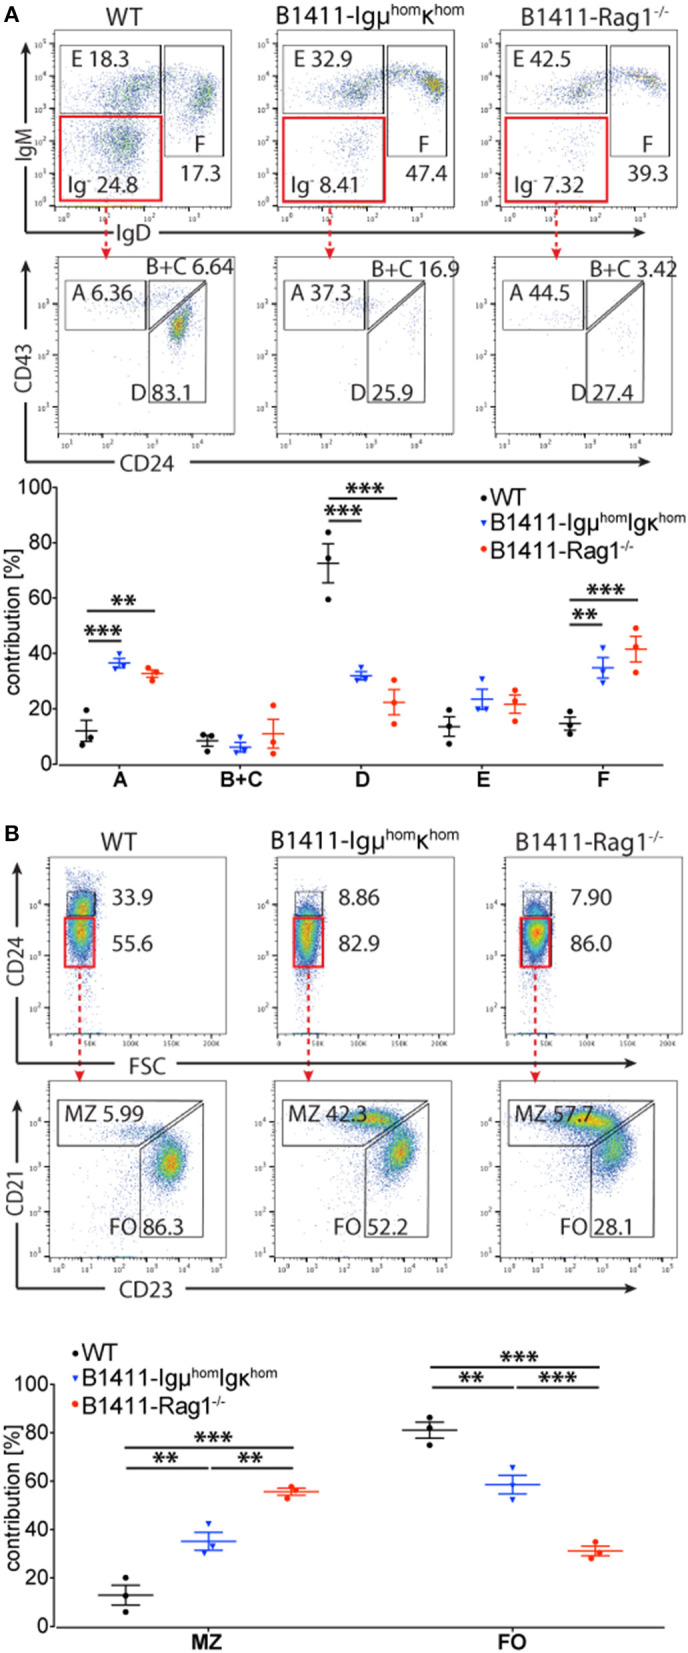
Development of autoimmune B1411 B cells. (A) Flow cytometric analysis of B cell development in the bone marrow showing the Hardy Fractions E and F in WT NOD, B1411-IgμhomIgκhom, and B1411-Rag1−/− mice. The Hardy Fractions A-D were determined within the Ig− population of indicated mice (top row). Dot plot showing frequencies of Hardy Fractions A-F in indicated mice (bottom row). Error bars are expressed as mean ±SEM. Initial gate on live B220+ CD3− CD4− CD8− Gr-1− CD11b− cells. (B) Flow cytometric analysis of B cell development in the spleen of WT NOD, B1411-IgμhomIgκhom, and B1411-Rag1−/− mice. Marginal Zone (MZ) and Follicular (FO) B cells were determined within the CD24Lo B cell subsets of indicated mice. Scatter dot plot showing frequencies of MZ and FO in indicated mice (bottom row). Error bars are expressed as mean ±SEM. Initial gate on live B220+ CD3− CD4− CD8− Gr-1− CD11b− cells. ***indicates p-value < 0.001. ** indicates p-value < 0.01.